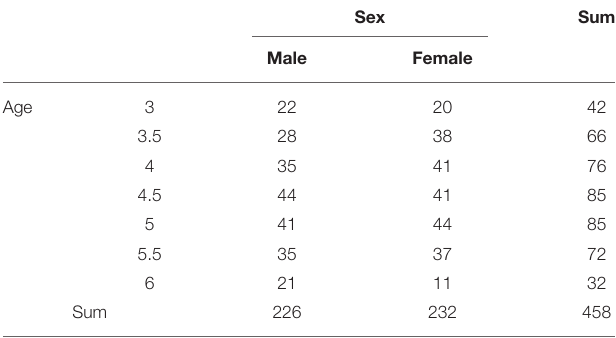
TABLE 1 | List of basic conditions of the participants.